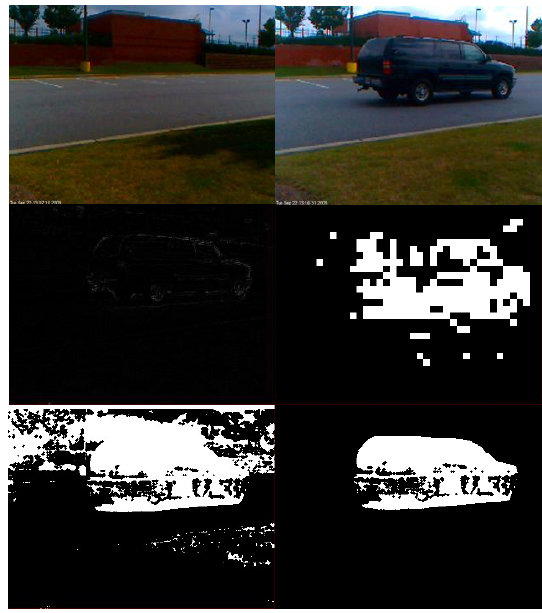
Figure 3. Change detection in challenging illumination conditions. First row: left – image of the scene that experience illumination changes, right – current image with foreground object. Second row: left - detected changes in the 1 st pyramid layer, right – thresholded detected changes in the 2 nd pyramid layer. Third row: left – foreground detection based on first layer background model, right –foreground mask adjusted based on detected changes from 1 st and the 2 nd pyramid layers It can be observed from tables 5, 6 that with our modification change detection algorithm is capable of removing a significant amount of false positives and almost preserves recall value. The difference between the performance achieved by our proposal and that of the original version in terms of F-measure is 32% and in terms of precision is 38,4%.